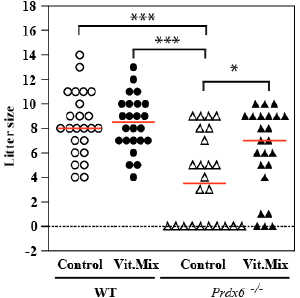
Figure 1. Number of pups sired by wild type (WT) or Prdx6 ‐ / ‐ males fed with control or Vit. Mix diets. Each circle or triangle corresponds to one litter from WT or Prdx6 ‐ / ‐ males, respectively. Open symbols correspond to males fed with the control diet, and black symbols correspond to males fed with the Vit. Mix diet. A horizontal red line represents the median of each group. * p ≤ 0.05; *** p ≤ 0.001, two ‐ way ANOVA and Tukey tests.